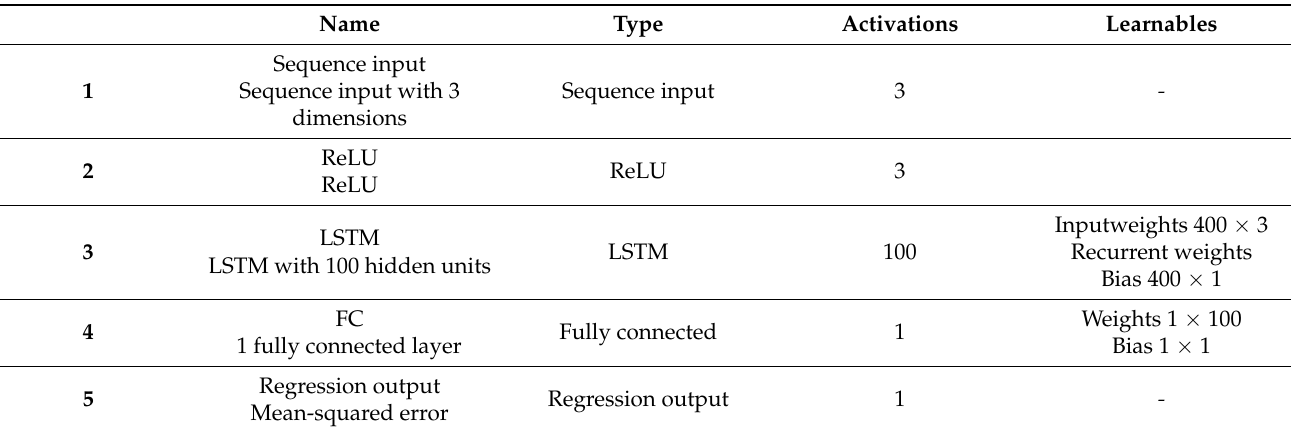
Table 2. Network analysis for proposed LSTM